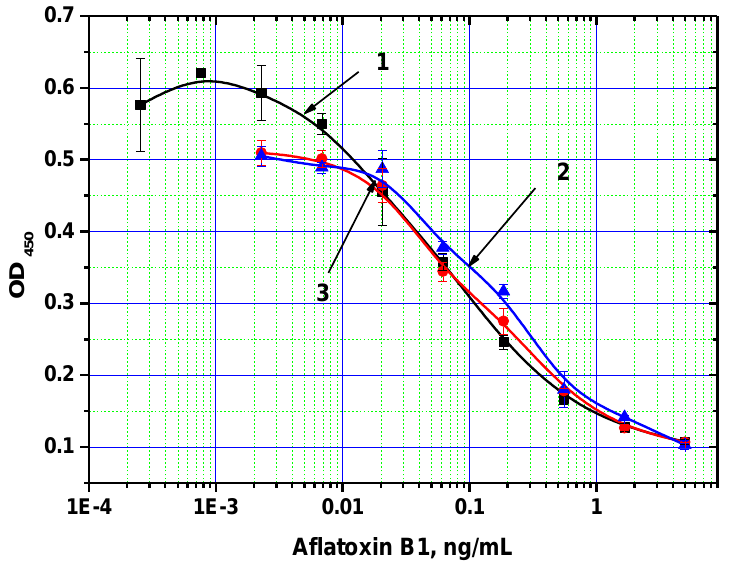
Figure 6. Concentration dependence of AFB1 detection when using MNP-based ELISA. A solution of methanol in buffer (1) and extracts of barley (2) and maize (3) were spiked with known concentrations of AFB1. The measurements were performed in